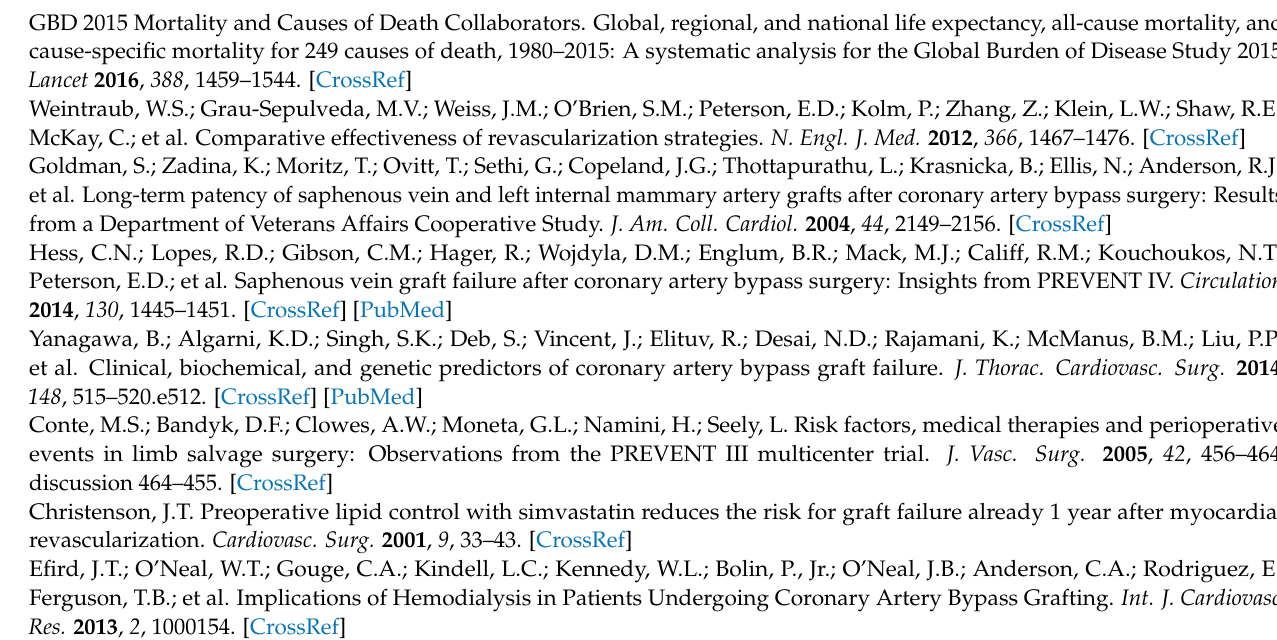
C. Endothelium inflammation score comparisons among all defined cell subsets. D. pseudo-time trajectory analysis of EC subsets. The trajectory was split by EC subsets on the left and shown as in pseudotime on the right. Figure S2: A: GO enrichment for upregulated genes expressed in ANGPTL7+ FB. B. Violin plot of mesenchymal cell canonical genes and FOXD1. Figure S3: Split UMAP plots of mural cells. Figure S4: Klf9 expression was upregulated in diabetic mice (A) and diabetic pigs (B). Figure S5: Cell ratio assessment for immune cells. Figure S6: The outgoing signals for each cell subsets in patient affected with diabetes mellitus. and non-diabetic patients were plotted separately. Cells of the same type were shown as the same color. DM: diabetes mellitus. Non_DM: non-diabetic patients. Results showed that CSF3, GDF, OSM, PVR and TRAIL signaling pathways were specifically found in patients with DM. Figure S7: Comparison IL6 expression between DM and non-DM in all cells and endothelial cells. Table S1: Signature expression of each cell subset. Table S2: DEG analysis of venous EC and valvular EC. Pct.1: venous EC, pct2. valvular EC. Table S3: co-expressed genes with KLF9 in mural